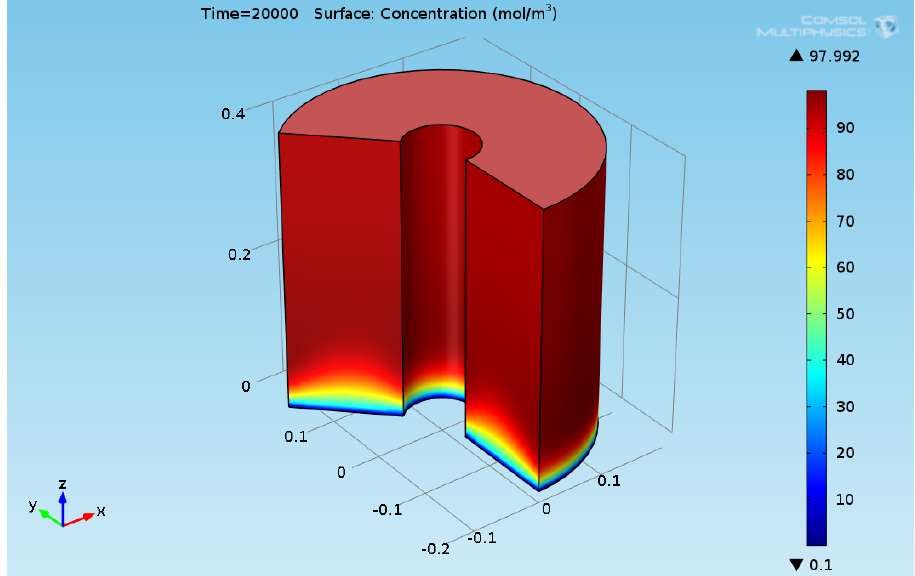
Figure 8. 3D plot of the concentration field of the FAME inside the esterification reactor.